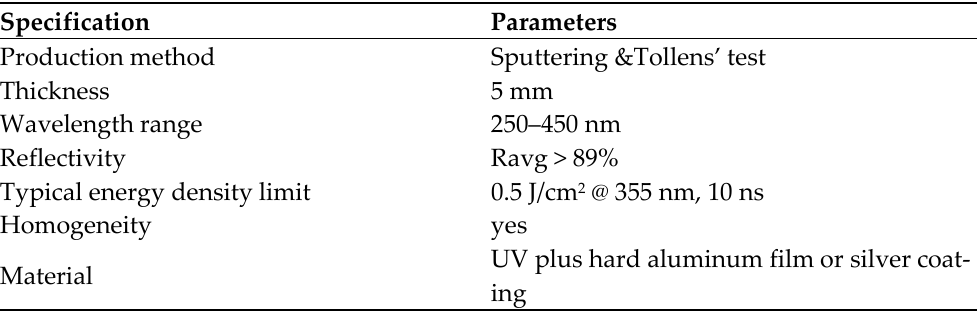
Table 2. The Parameters of